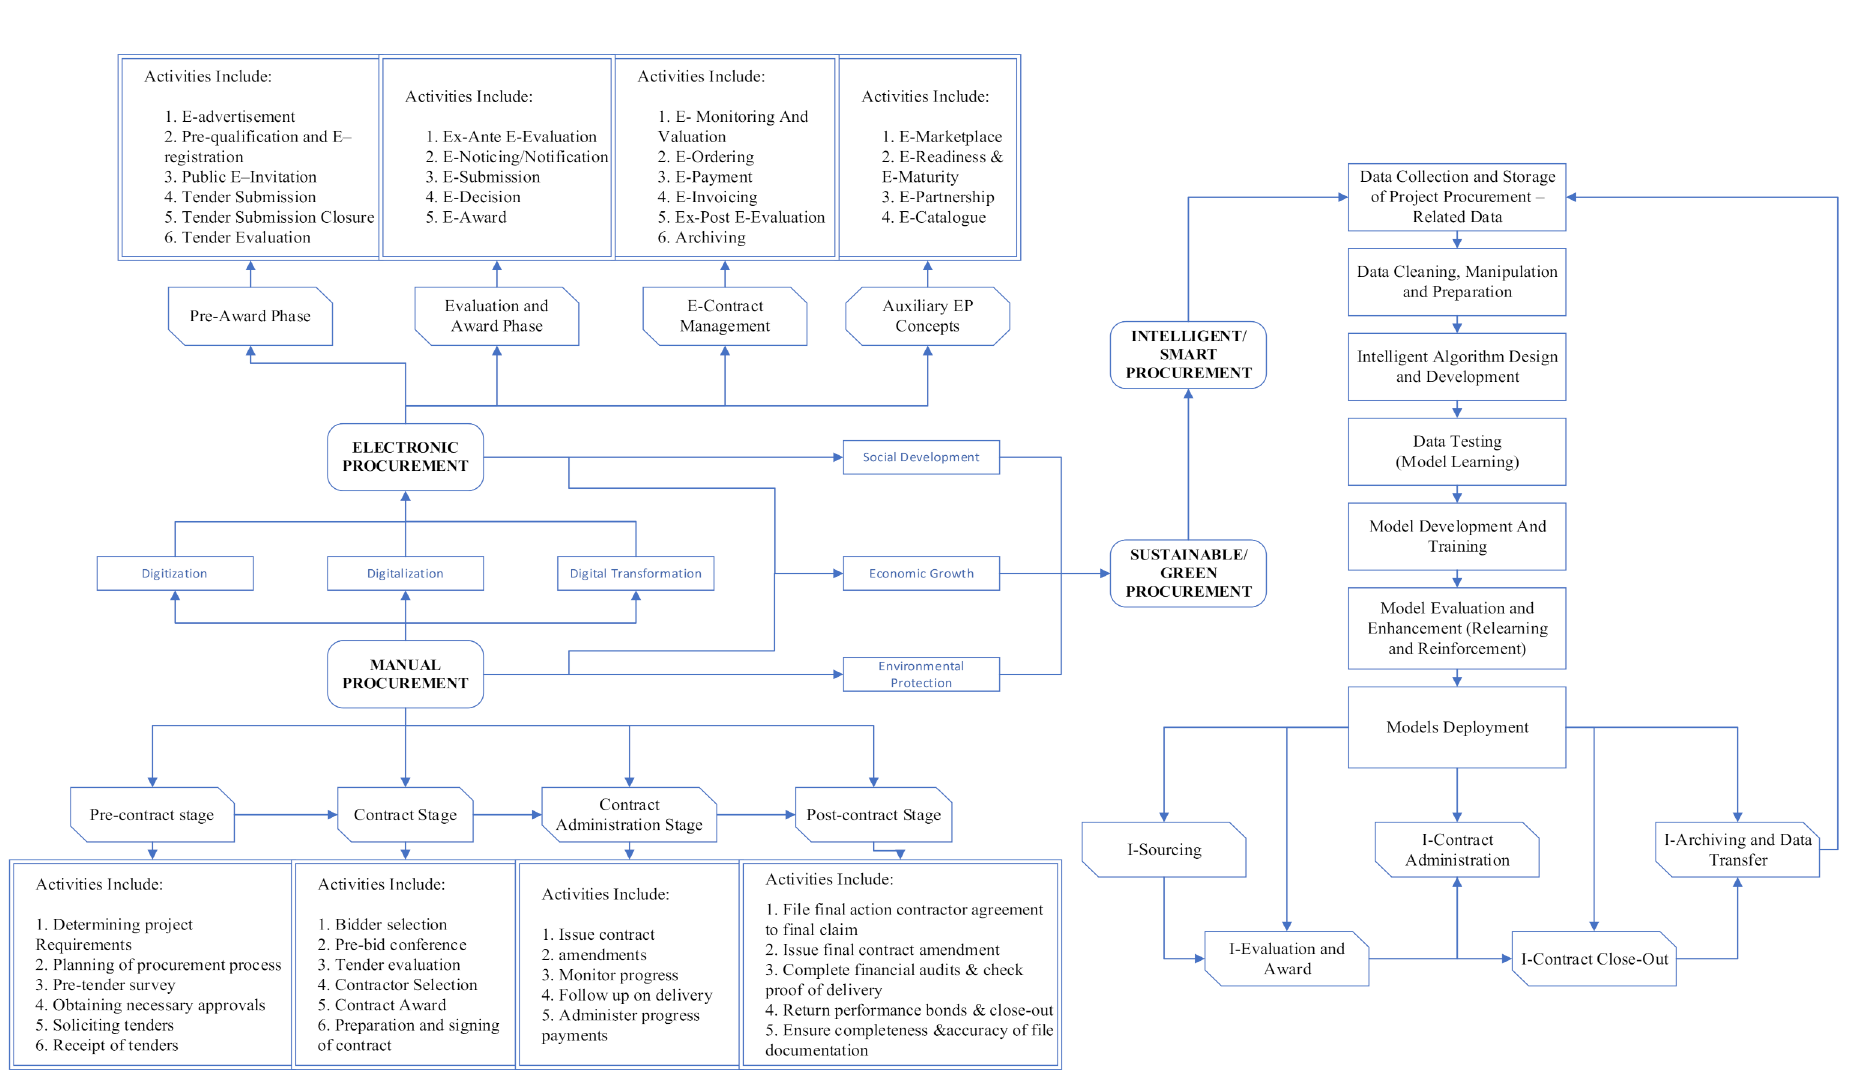
Figure 6. Conceptual framework of IP development; Source: authors’